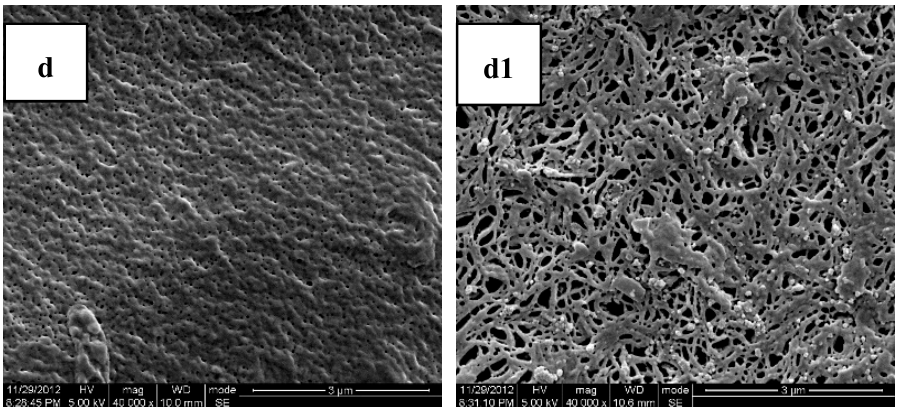
Figure 3. Scanning Electron Microscopy (SEM) photos of the cross sections and molded surfaces of the PLA / PEG / MB samples after 120 days immersion in PBS (( a , a1 ) PLA; ( b , b1 ) PLA-20%PEG6000; ( c , c1 ) PLA-35%PEG6000; ( d , d1 ) PLA-50%PEG6000; ( a – d ) cross section; ( a1 – d1 ) molded surface).